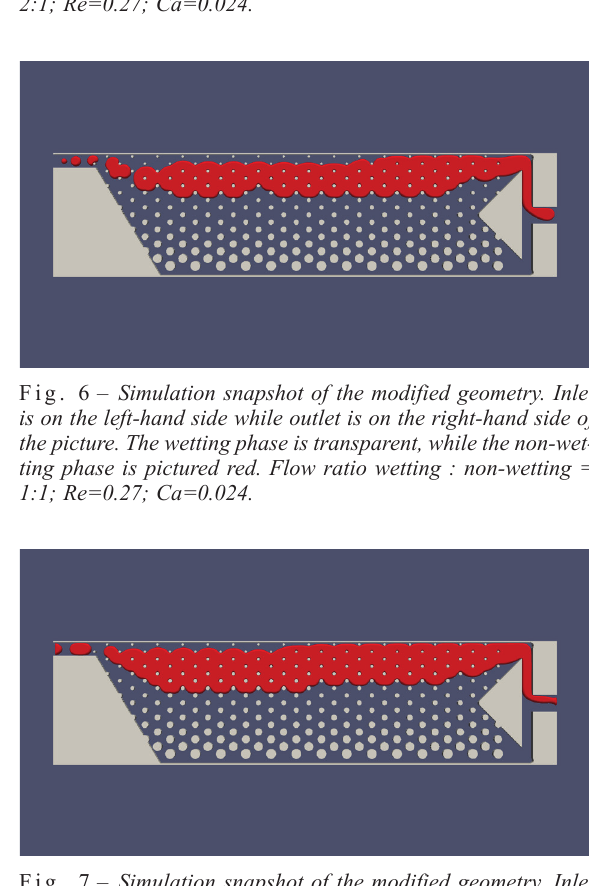
Fig. 7 – Simulation snapshot of the modified geometry. Inlet is on the left-hand side while outlet is on the right-hand side of the picture. The wetting phase is transparent, while the non-wet- ting phase is pictured red. Flow ratio wetting : non-wetting = 1:2; Re=0.27;